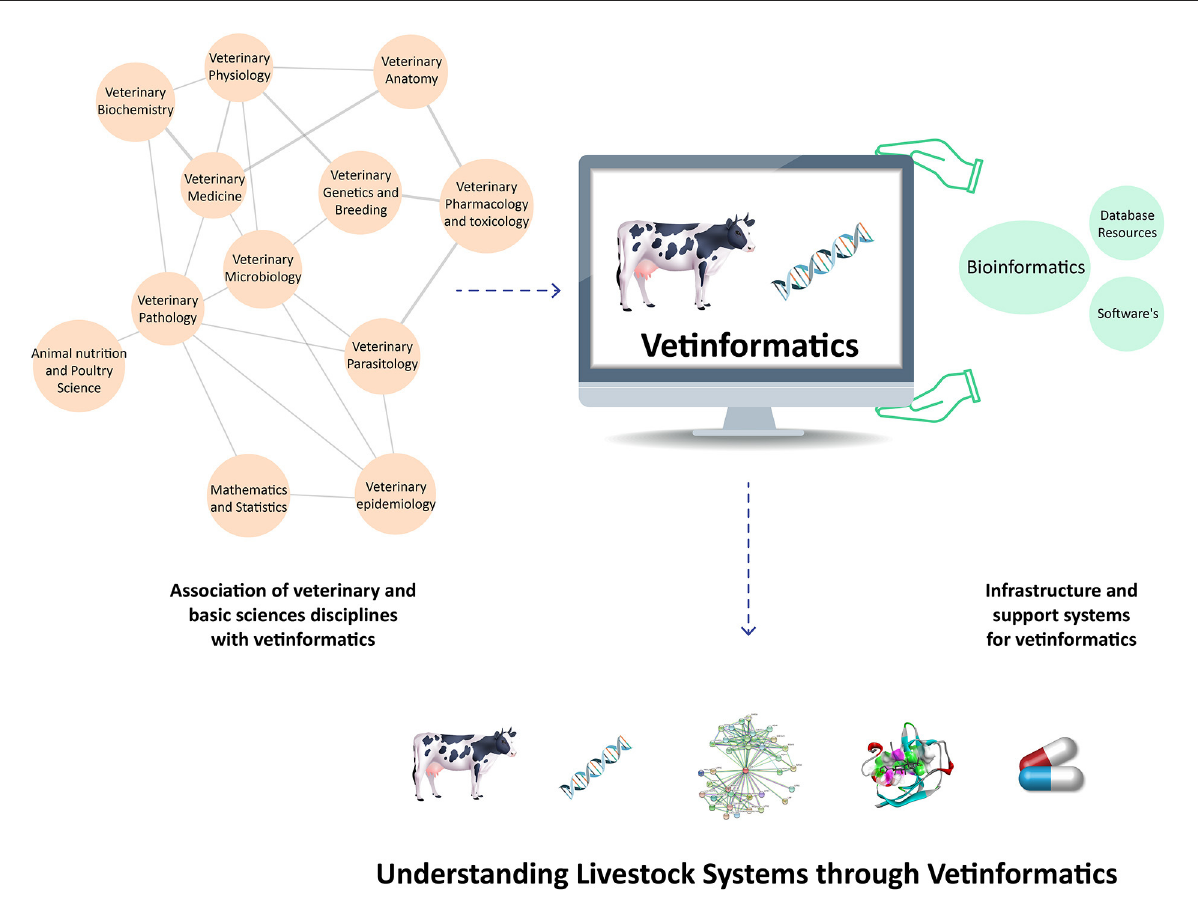
FIGURE1 Integration of veterinary sciences, basic science disciplines, and support systems to create vetinformatics, enabling a better understanding of livestock systems in veterinary